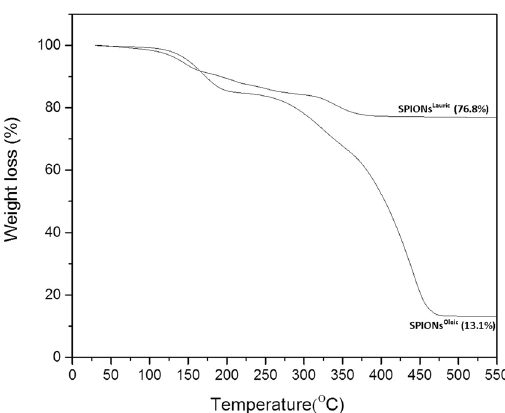
Figure 7. Thermogravimetric curves of SPIONs Lauric and SPIONs Oleic showing the percentage of weight loss (%) between 27 °C and 550 °C under nitrogen flow at the heating rate of 10